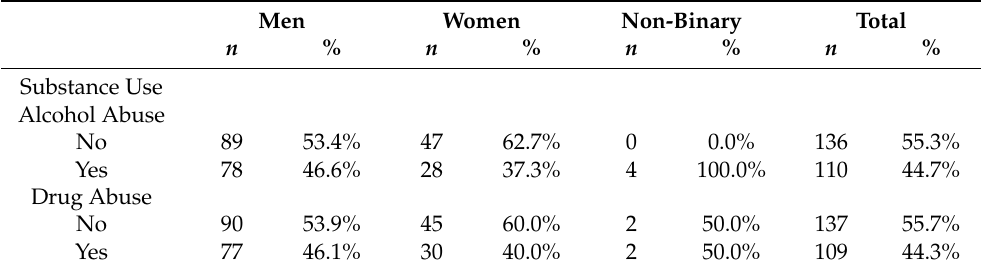
Figure 2. ( a ) General health and ( b ) Emotional well-being scores among n = 246 unsheltered PEH in Nashville, TN as measured by the SF-36. Dashed lines indicate mean scores. Table 6. Prevalence of substance abuse and emergency department utilization within past 12 months among n = 246 unsheltered PEH in Nashville,